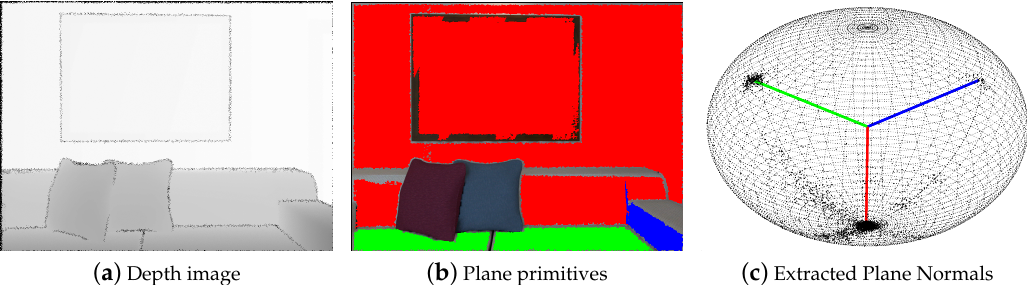
Figure 4. Result of the plane normal extraction: ( a ) depth image of Frame 0 in the ‘Living Room 1’ sequence of the ICL-NUIM dataset; ( b ) detected planes using fast plane extraction method; ( c ) extracted plane normals on the unit sphere. The plane primitives in the image domain and their corresponding extracted normal vectors are in the same